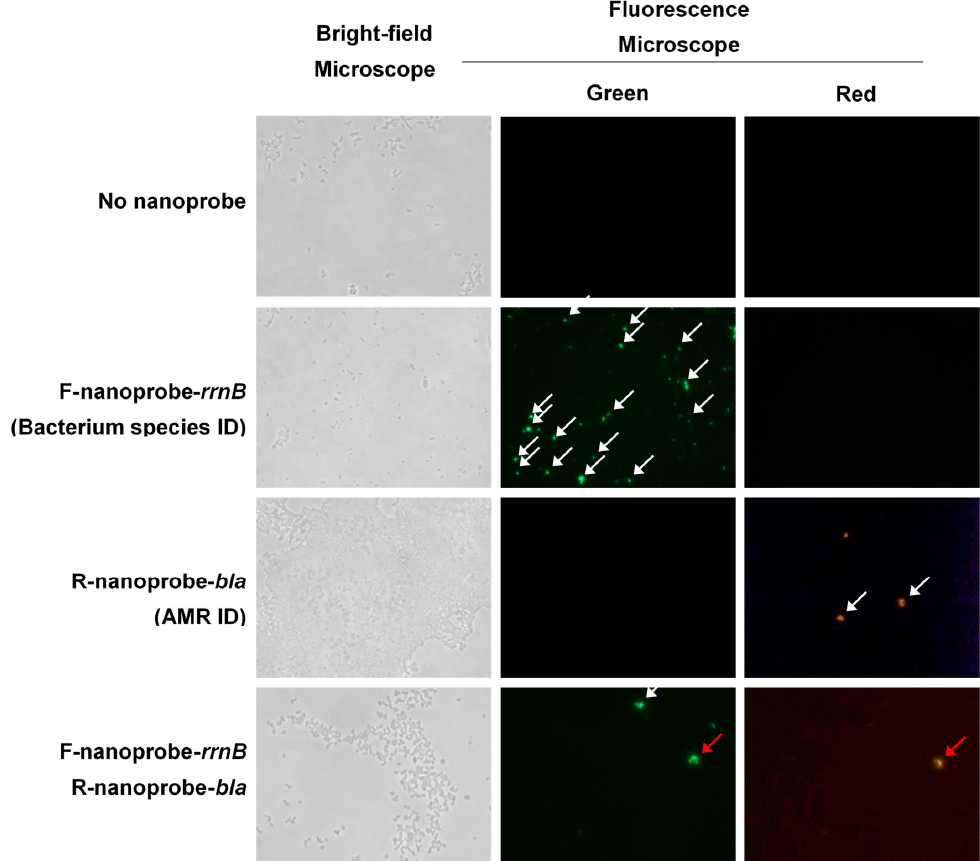
Figure 5. Bright-field and fluorescence images of E. coli for the identification of bacterium species and antimicrobial resistance (ampicillin-resistant) E. coli using the nanoprobe-combined FISH method. F-nanoprobe-rrnB recognizes 16s rDNA sequence (Bacterium species ID) of E. coli and provides green fluorescence signals in the second row. R-nanoprobe-bla recognizes beta-lactamase sequence of ampicillin-resistant E. coli and provides red fluorescence signals the third row. The fourth row was applied both F-nanoprobe-rrnB and R-nanoprobe-bla. The first row indicates the background images under bright-field and fluorescence microscope. The white arrows marked E. coli cells containing single gene rrnB or bla under fluorescence microscope. The red arrow indicates an E. coli cell containing both rrnB and bla genes.